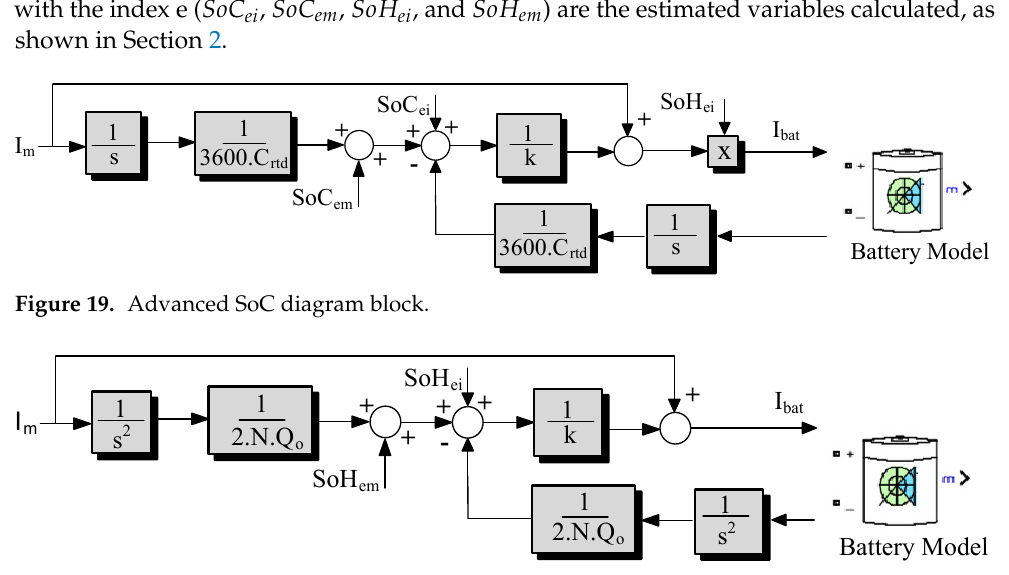
Figure 20. Advanced SoC diagram